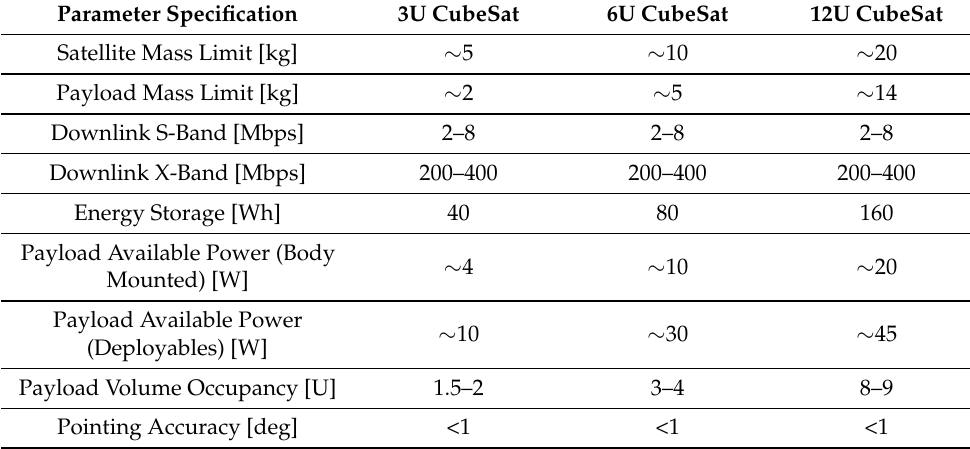
Table 1. Typical constraints on payload requirements in 3U, 6U, and 12U class CubeSats (based on private communication with